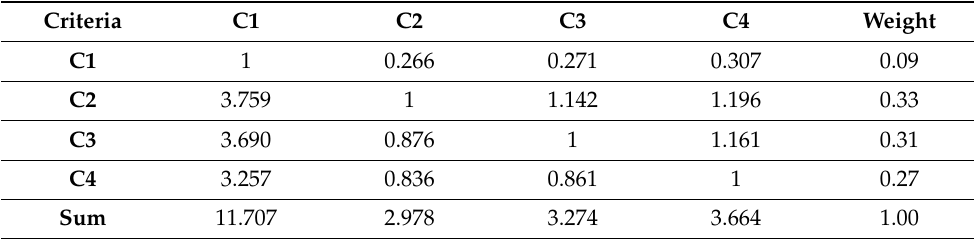
Table 11. Pairwise comparison matrix for agricultural land use suitability using the geometric mean of the preferences with the computed weights.